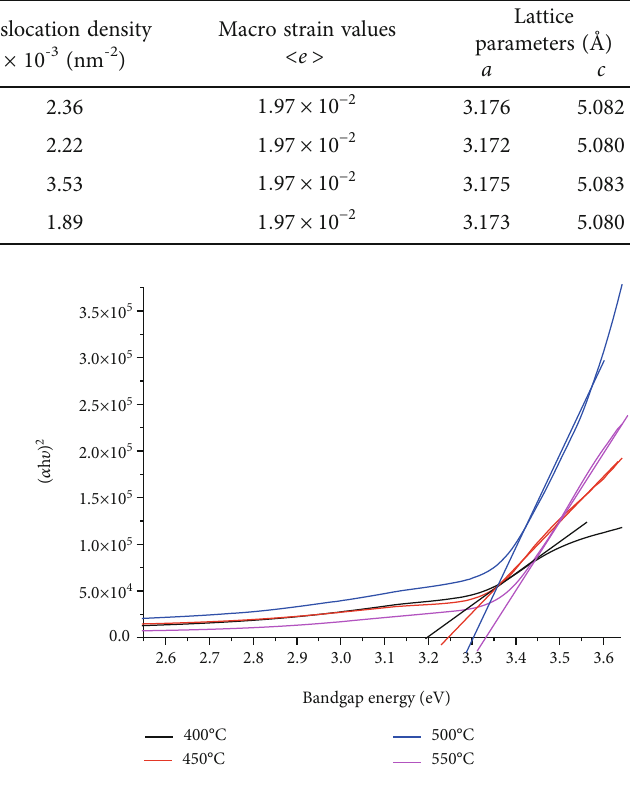
Figure 5: Absorbance spectra of Mg-doped ZnO thin fi lms at di ff erent annealing temperatures.